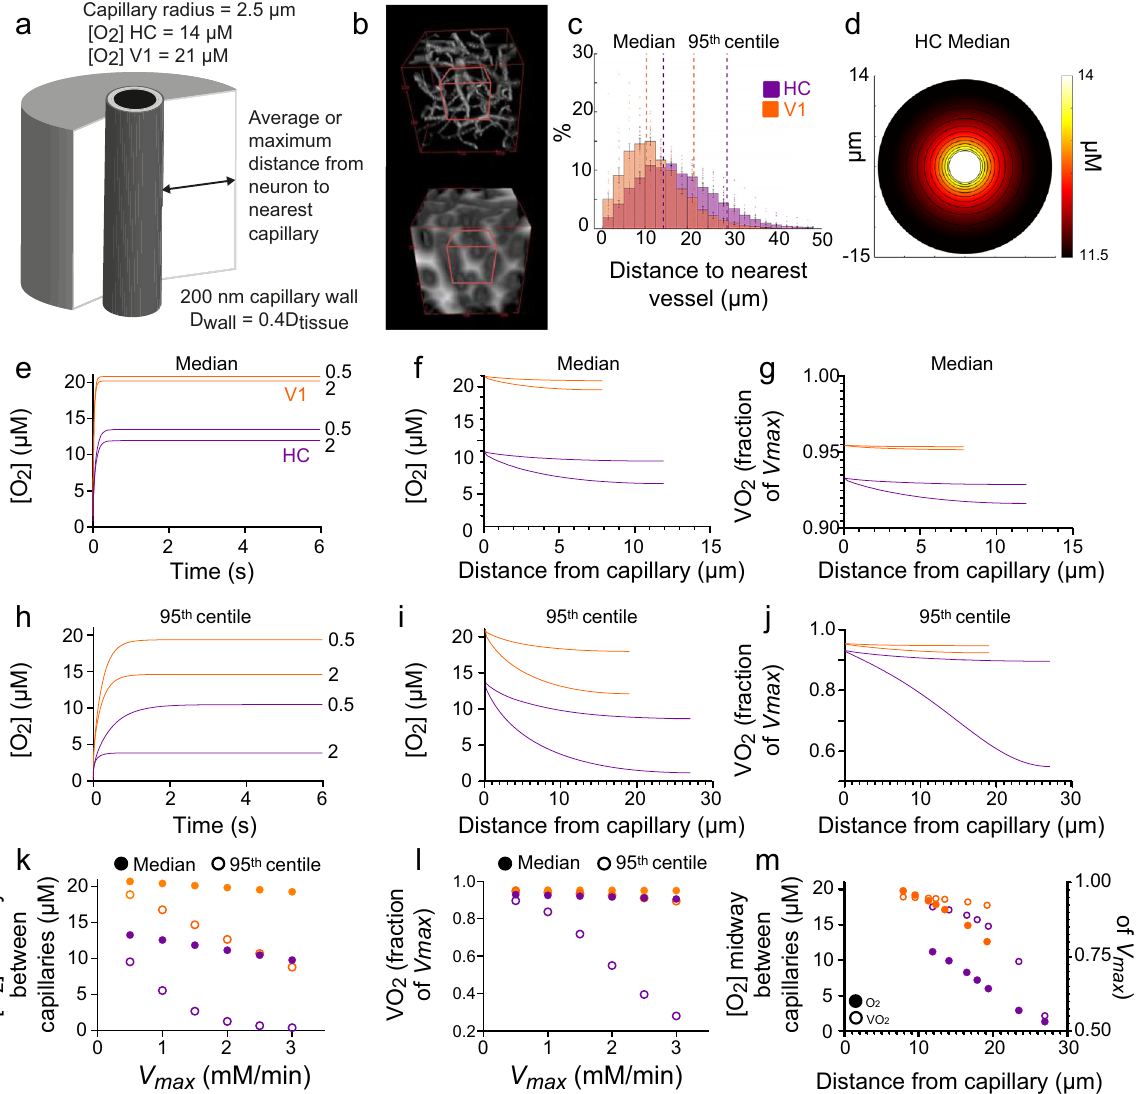
Fig. 7 Modelling O 2 diffusion in brain tissue. a Schematic of radial diffusion model. b Top: example in vivo Z-stack (250 μ m³) of fl uorescent dextran- fi lled vasculature in CA1. Bottom: 3D distance map generated from the z-stack. White pixels denote high values and black low values. Red cube shows example 100 μ m³ substack used to generate c . c Average histogram of the distance of each pixel from a capillary (four mice per region, the value for each mouse representing the average of fi ve non-overlapping substacks sampled from one Z-stack). Dotted lines mark the 50th and 95th percentiles for HC (purple) and V1 (orange), data are presented as mean ± SEM between animals. d Example heatmap showing oxygen diffusion from a capillary in HC separated from the next capillary by twice the median tissue distance from a capillary (14.4 μ m). Simulated time courses from initial conditions of zero [O 2 ] for HC (purple) and V1 (orange) for tissue at e the median or h 95th centile distance from a capillary, showing that steady-state is reached by 6 s (when [O 2 ] pro fi les were extracted). Lines represent different values of V max as labelled. [O 2 ] pro fi les across tissue for capillary separations of twice the tissue f median and i 95th centile distance from a capillary. O 2 consumption rate as a fraction of V max (VO 2 ) for g median and j 95th centile capillary spacing conditions, calculated from oxygen pro fi les shown in e & h . k [O 2 ] and l VO 2 reached midway between capillaries for different values of V max in HC (purple) and V1 (orange) at median (solid symbols) or 95th centile (hollow symbols) capillary spacings. m [O 2 ] (solid symbols) and VO 2 (hollow symbols) reached midway between capillaries for capillaries spaced at twice the 50th, 60th, 70th, 80th, 90th and 95th centiles (from left to right for each range of solid or hollow dots) of tissue distance from a vessel in HC (purple) and V1 (orange). Source data are provided as a Source Data fi